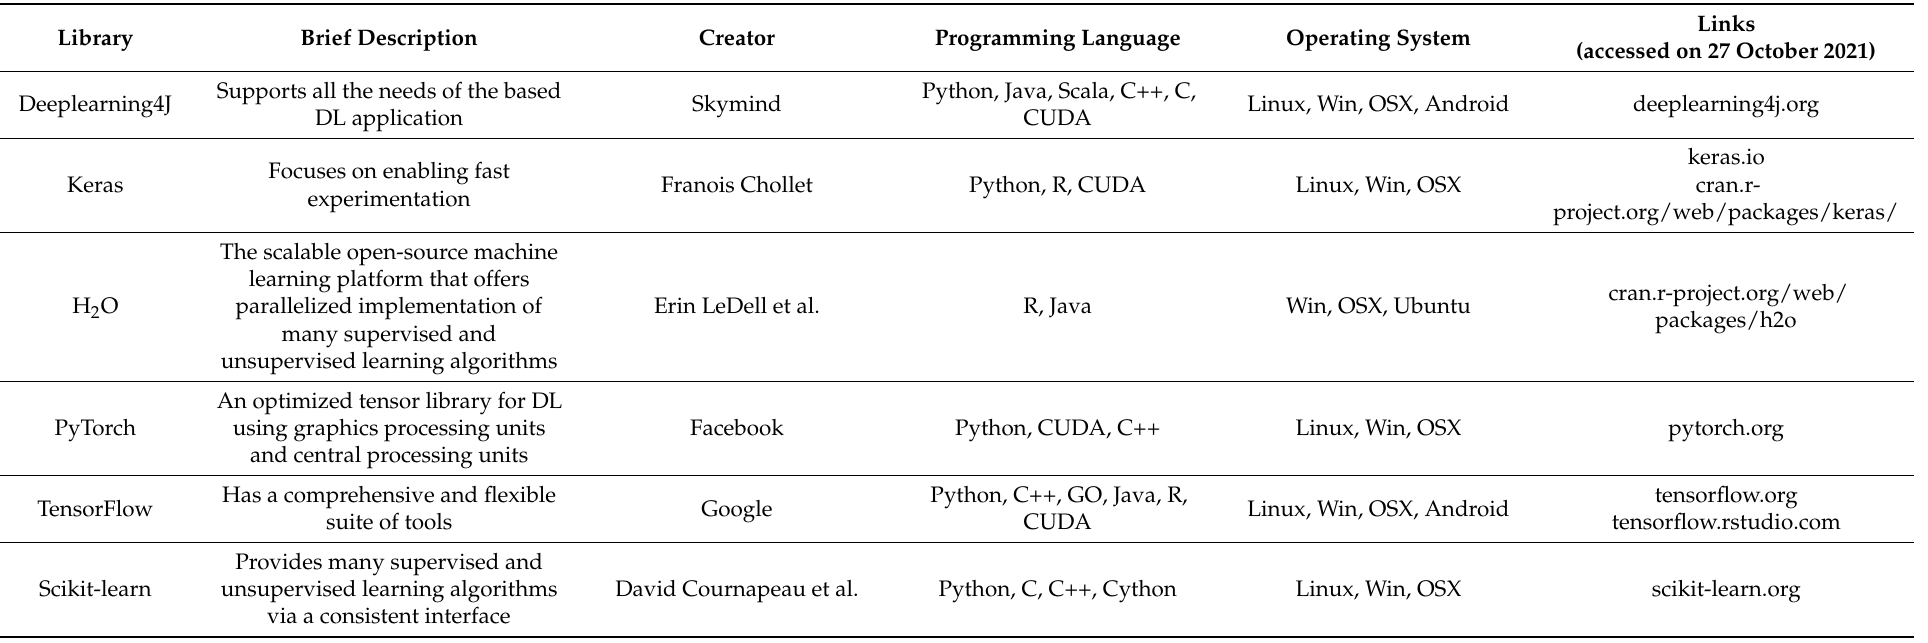
Table 6. Comparison of libraries used for training a DL